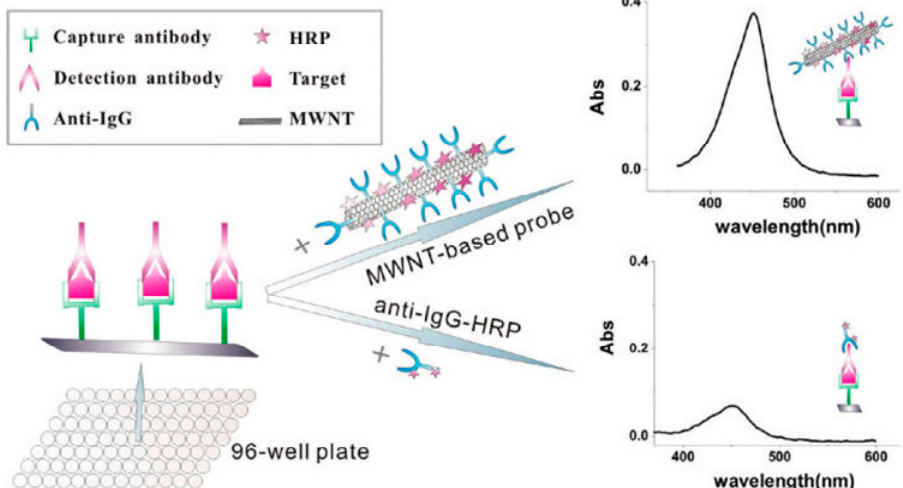
Figure 15. Scheme of the colorimetric strategy for the detection of ataxia telangiectasia mutated (ATM) using an MWNT-based probe compared with conventional ELISA. Reproduced with permission from [159]. Copyright American Chemical Society, 2011.